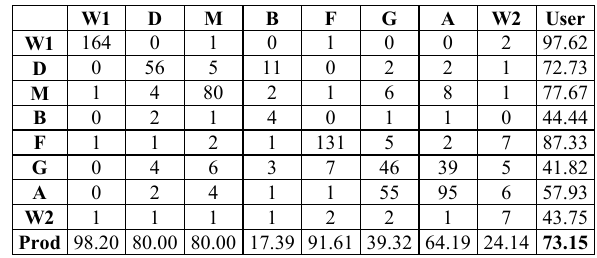
Table 3. Confusion matrix for Scenario 2. Note: W1=Water, D=Developed, M=Mining, B=Barren, F=Forest, G=Grassland, A=Agriculture, W2=Wetland.